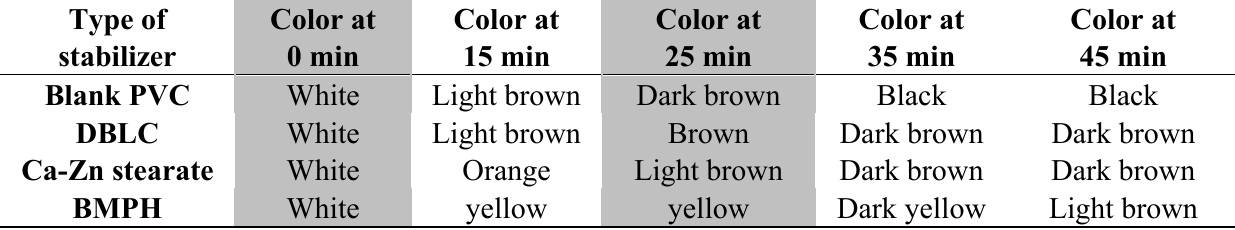
Table 2. Extent of discoloration of thermally degraded rigid PVC at 180 °C in air for various time intervals, in presence of different stabilizers.